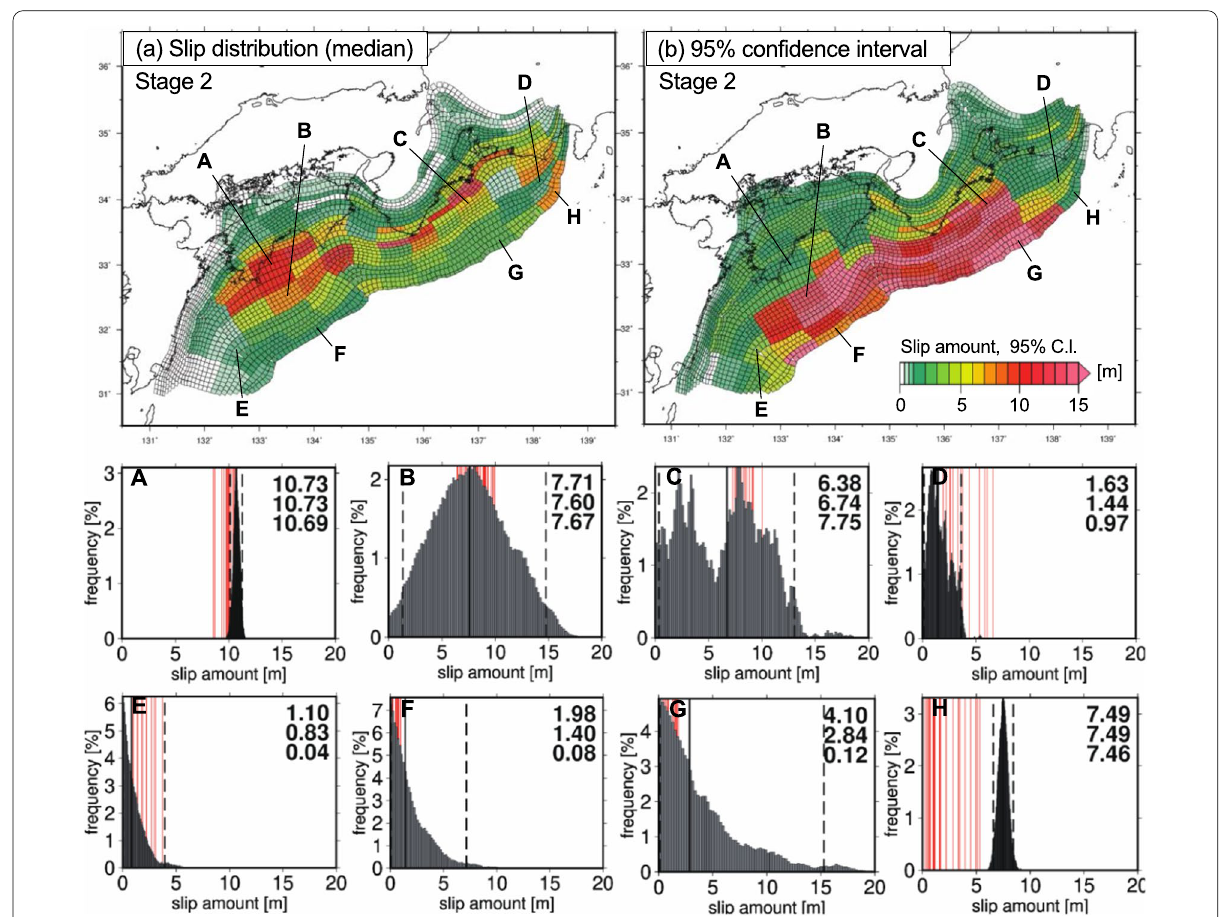
Fig. 6 Examples of posterior probability density functions (PDFs) in stage 2. A–G: slip amounts of eight perturbation groups. The limits of the horizontal axis are constant from 0 to 20 m. Solid and dotted black lines show the median and the 95% confidence intervals (CI). The solid red lines show the assumed slip amount in the background subfault of the perturbation group. Inserted values indicate mean, median, and mode (from the top to bottom). A, B, and F shows the area off Cape Ashizuri, where the estimated slip was large, arranged in the fault dip direction. These tendencies can also be confirmed for C and G. E and H shows the area, where the assumed slip amounts are